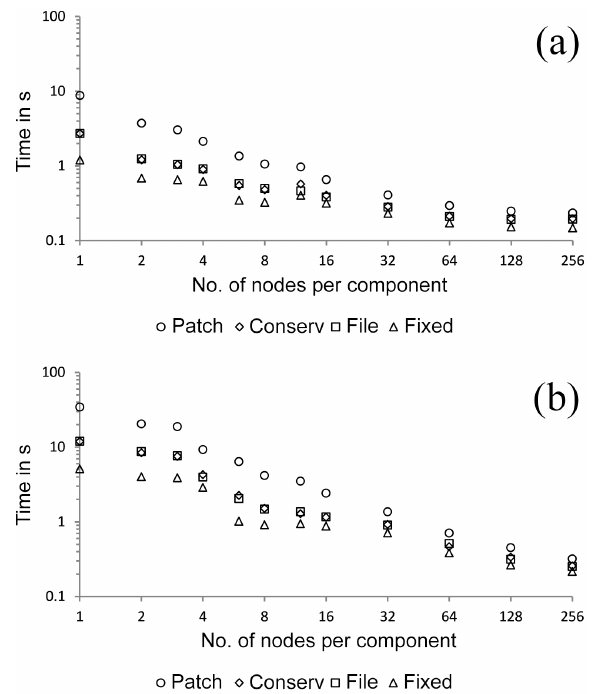
Figure 4. Time required for ping-pong exchange between (a) an ICONR2B06 and 405 × 405 cubed-sphere grid and (b) an ICONR2B07 and 810 × 810 cubed-sphere